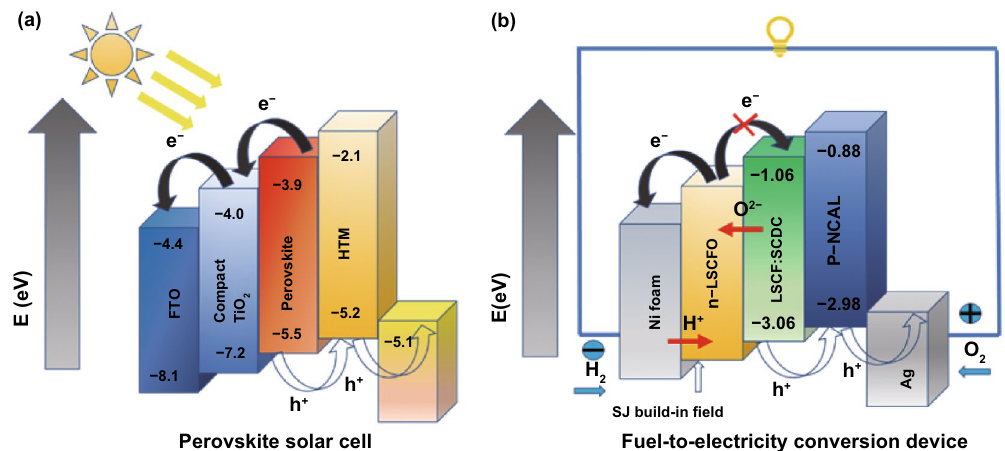
Fig. 8 Energy level diagram of a perovskite solar cell, b fuel‑to‑electricity conversion device inspired by the perovskite solar cell structure. Reproduced with permission from Ref. [11]. Copyright 2016